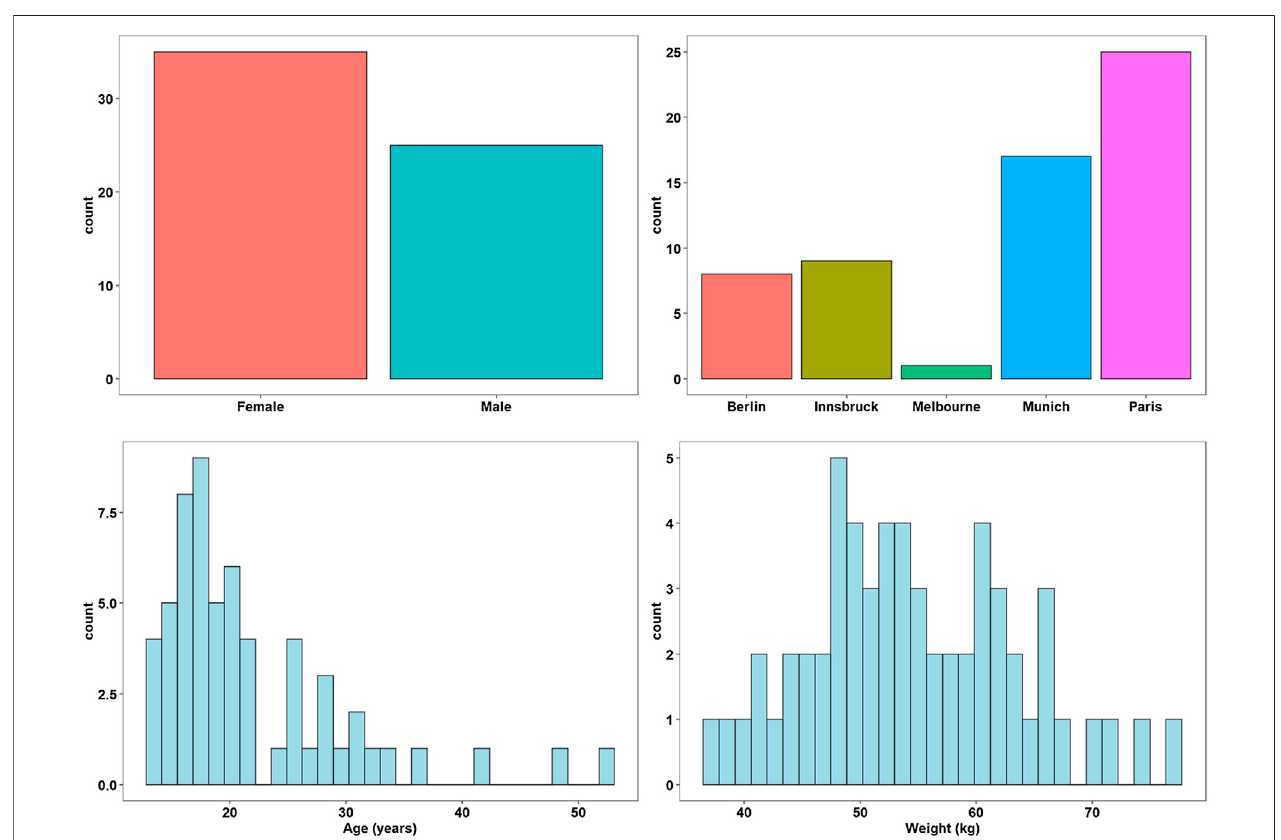
FIGURE 1 | Demographic factors of